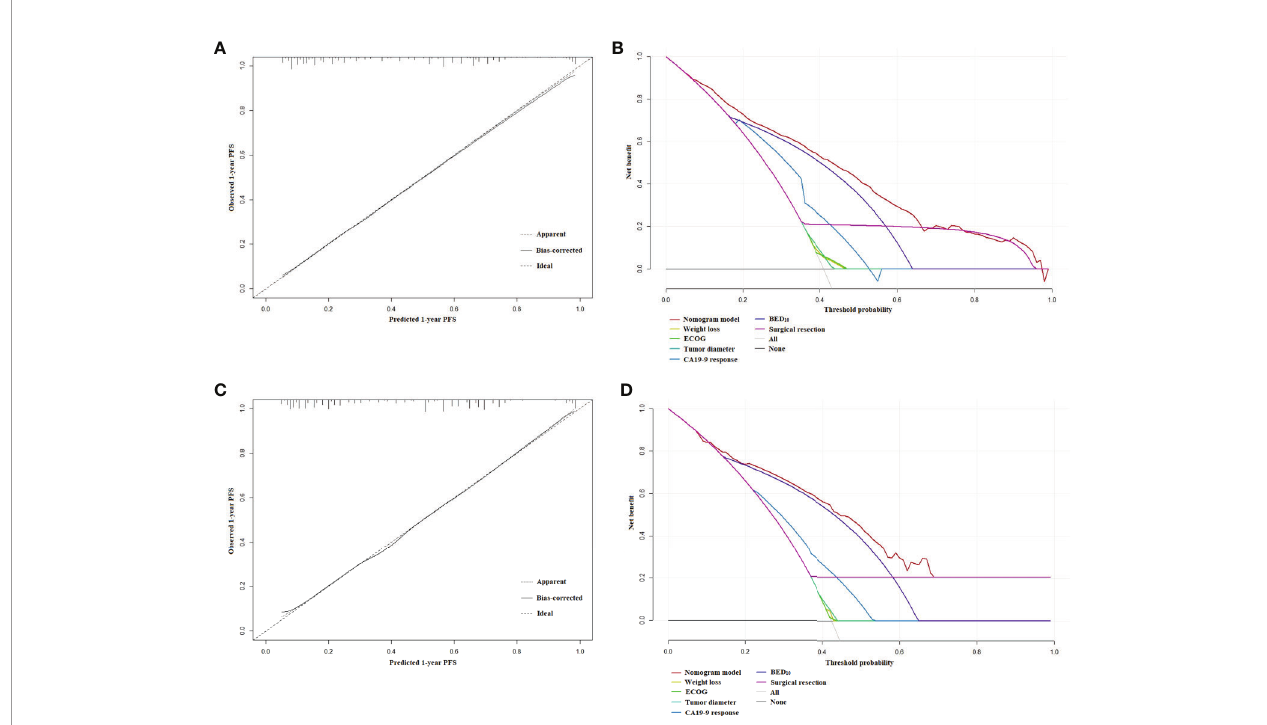
FIGURE 4 | (A) The calibration plot of PFS at 1 year in the development cohort. (B) Net bene fi t in relation to threshold probability of PFS at 1 year in the development cohort. (C) The calibration plot of PFS at 1 year in the validation cohort. (D) Net bene fi t in relation to threshold probability of PFS at 1 year in the validation